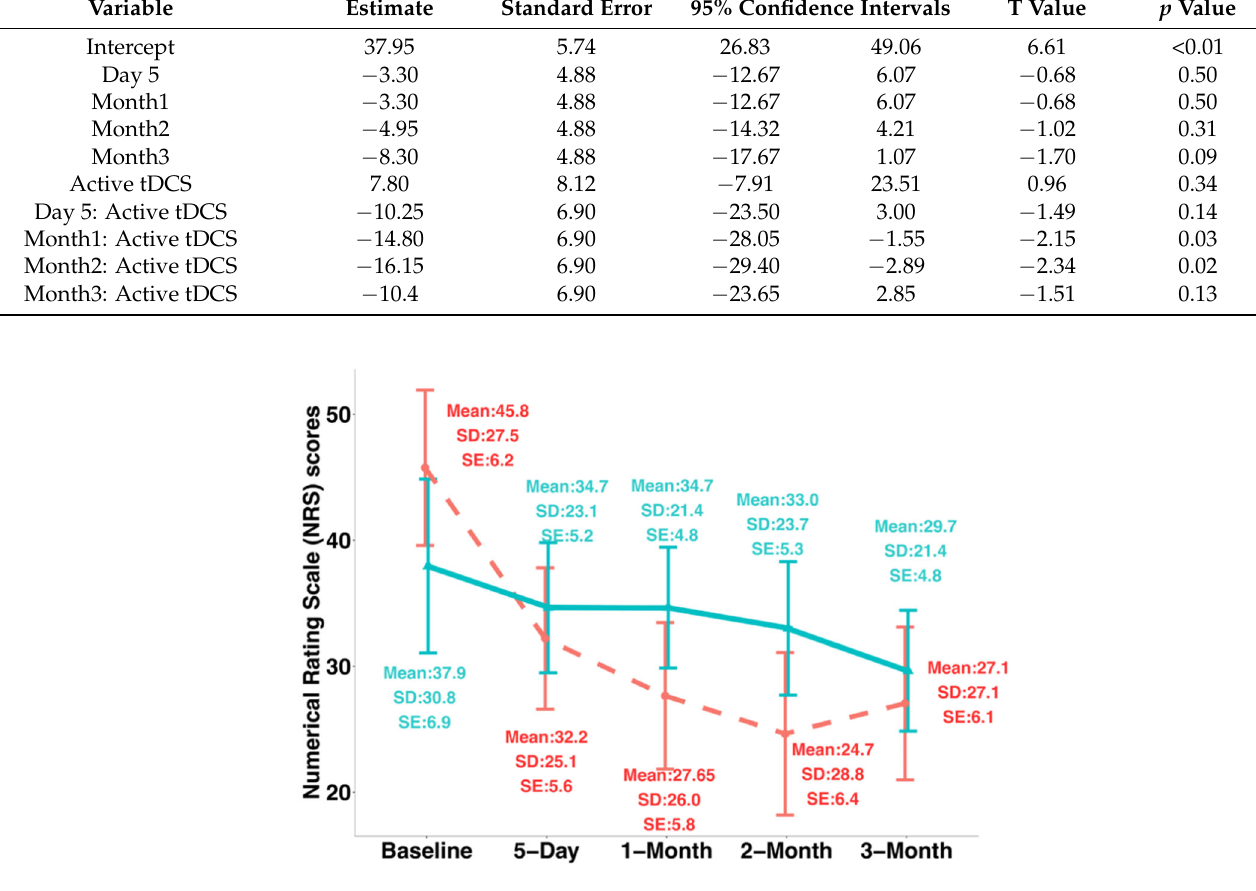
Figure 3. Mobilization Observation Behaviour Intensity Dementia (MOBID) scores over time of the active and the sham tDCS groups ( n = 40). The dashed red line represents the mean MOBID scores of the active tDCS group, and the solid green line represents the mean MOBID score of the sham tDCS group. We further employed the generalized estimating equation (GEE) model to examine the effects of selected covariates on NRS and MOBID scores over all the time points (Base ‐ line, Day 5, Month 1, Month 2, and Month 3). The results showed that: (1) the group indi ‐ cator ( p ‐ value < 0.001), age ( p ‐ value < 0.01), weight ( p ‐ value < 0.01), and race (Black African American vs. White, p ‐ value < 0.01) were significantly associated with the changes of NRS